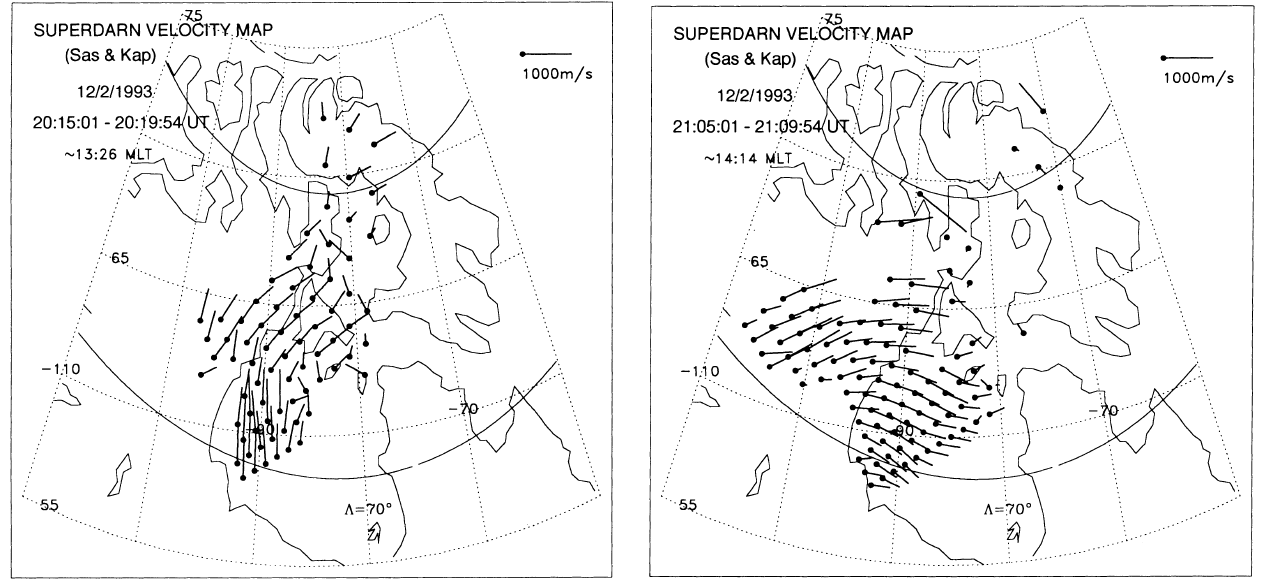
Fig. 15. Polar cap convection observed by the Saskatoon-Kapuskasing pair of